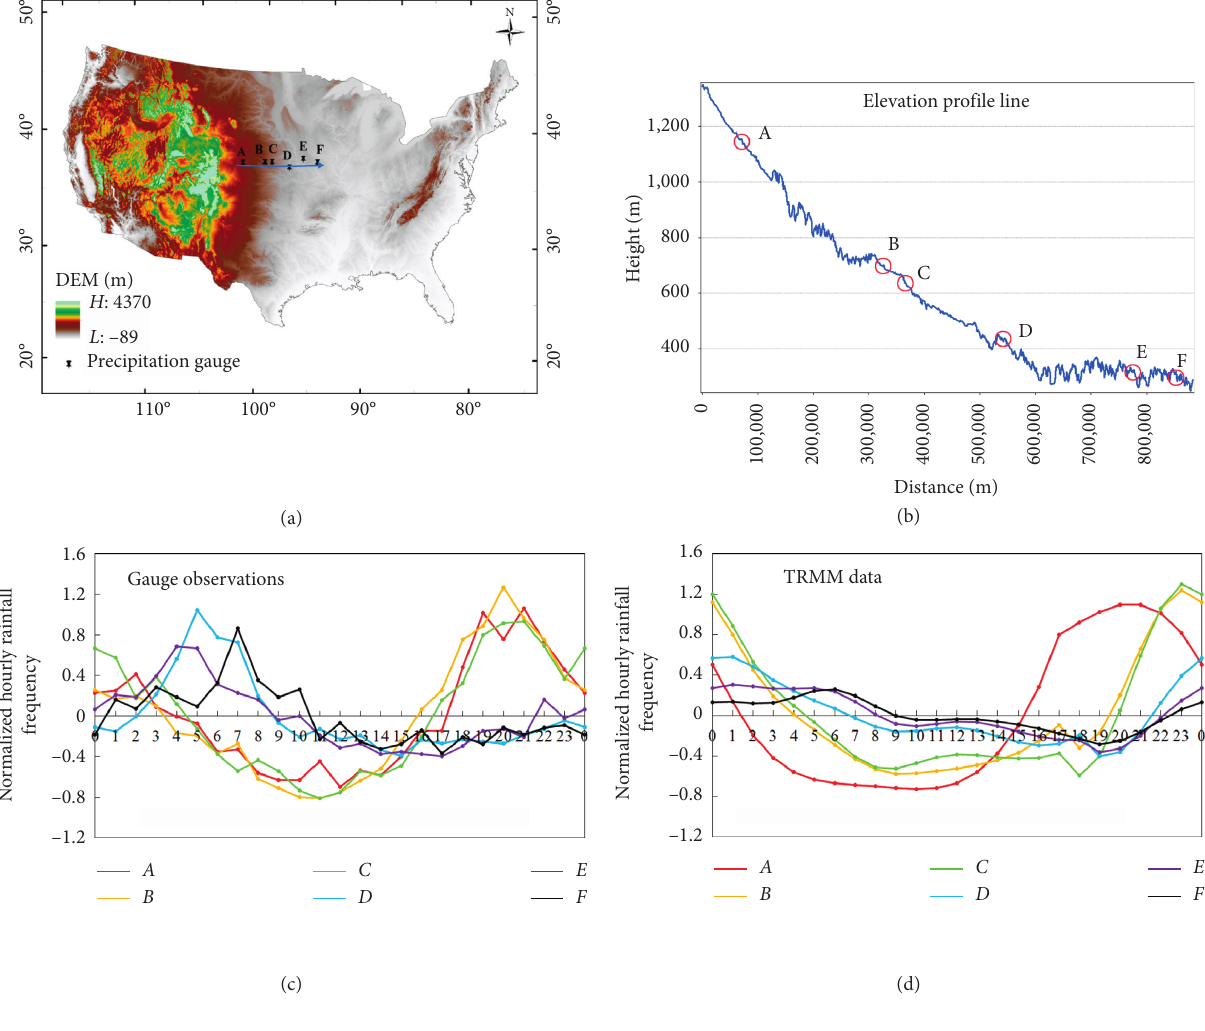
Figure 8: (a) Locations of the six precipitation gauge stations. (b) Elevation profile line along the six stations, with directional indicator arrow. (c) Curves of normalized hourly gauge precipitation frequency. (d) Curves of normalized hourly TRMM precipitation